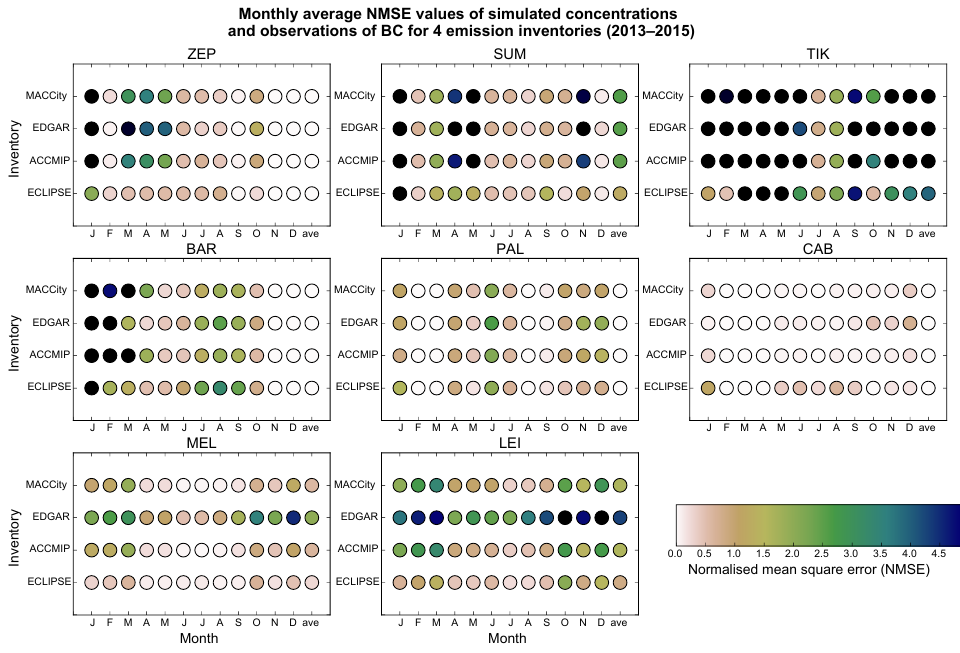
Figure 5. Monthly average NMSE values due to use of different emission inventories (ECLIPSEv5, ACCMIPv5, EDGAR_HTAPv2.2, MACCity) for the eight stations with complete data in the period 2013–2015. The annual mean is denoted as